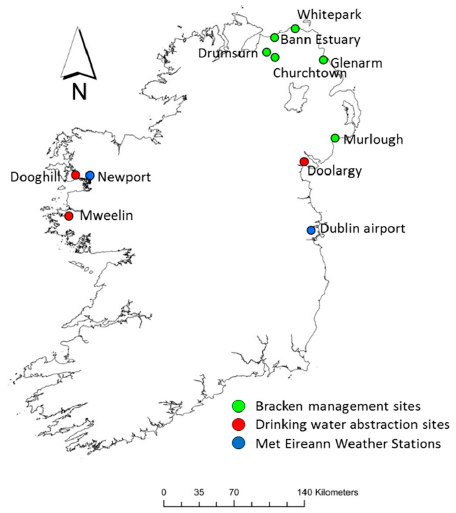
Figure 2. Map of the island of Ireland with locations of study sites and weather stations